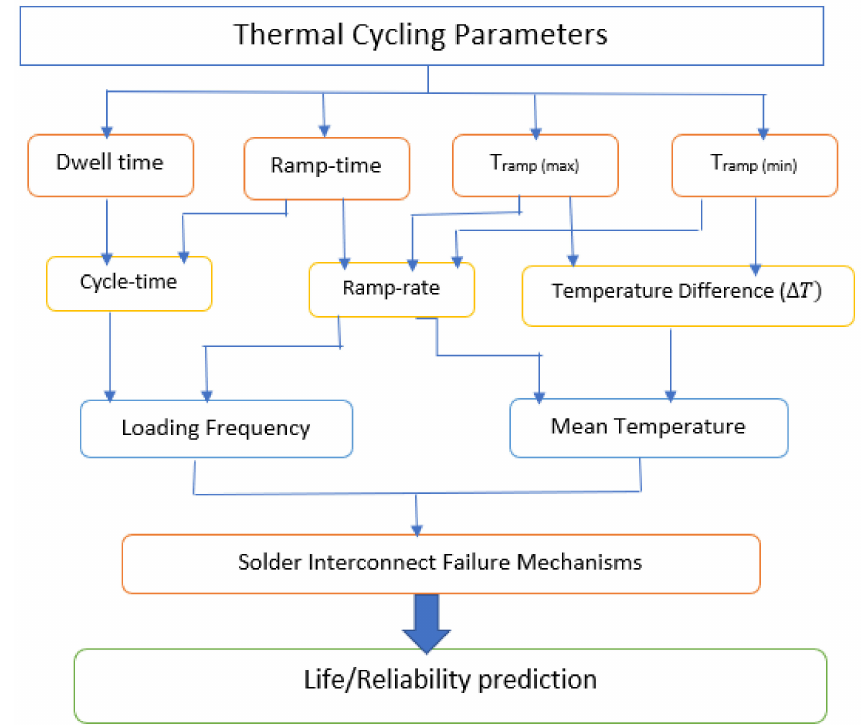
Figure 1. Relationships between thermal cycle